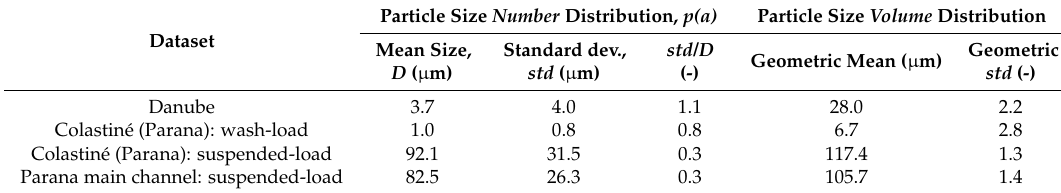
Table 1. Particle size distributions (PSDs) first and second order moments averaged among entire datasets.